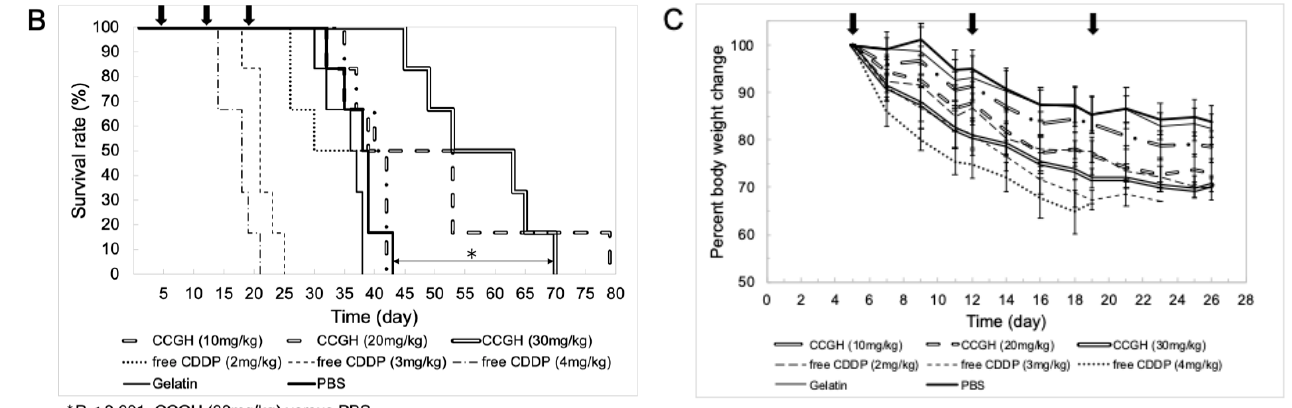
Figure 7. In vivo anticancer efficacy and toxicity evaluation after treatment in a mouse model with peritoneal metastases. ( A ) A schema of animal experiments. ( B ) Survival time profiles. CCGH (10 mg/kg; double dot-dash line), CCGH (20 mg/kg; double dashed line), CCGH (30 mg/kg; double line), free CDDP solution (2 mg/kg; dotted line), free CDDP solution (3 mg/kg; dashed line), free CDDP solution (4 mg/kg; dot-dash line), gelatin solution (thin solid line), and PBS (thick solid line). ( n = 6). Drugs were injected at the time indicated by arrows (day 5, 12, and 19). ( C ) Body weight change profiles from the first injection (day 5) up to 7 days after the third injection (day 26). CCGH (10 mg/kg; double dot-dash line), CCGH (20 mg/kg; double dashed line), CCGH (30 mg/kg; double line), free CDDP solution (2 mg/kg; dotted line), free CDDP solution (3 mg/kg; dashed line), free CDDP solution (4 mg/kg; dot-dash line), gelatin solution (thin solid line), and PBS (thick solid line). ( n = 6). Drugs were injected at the time indicated by arrows (day 5, 12, and 19).